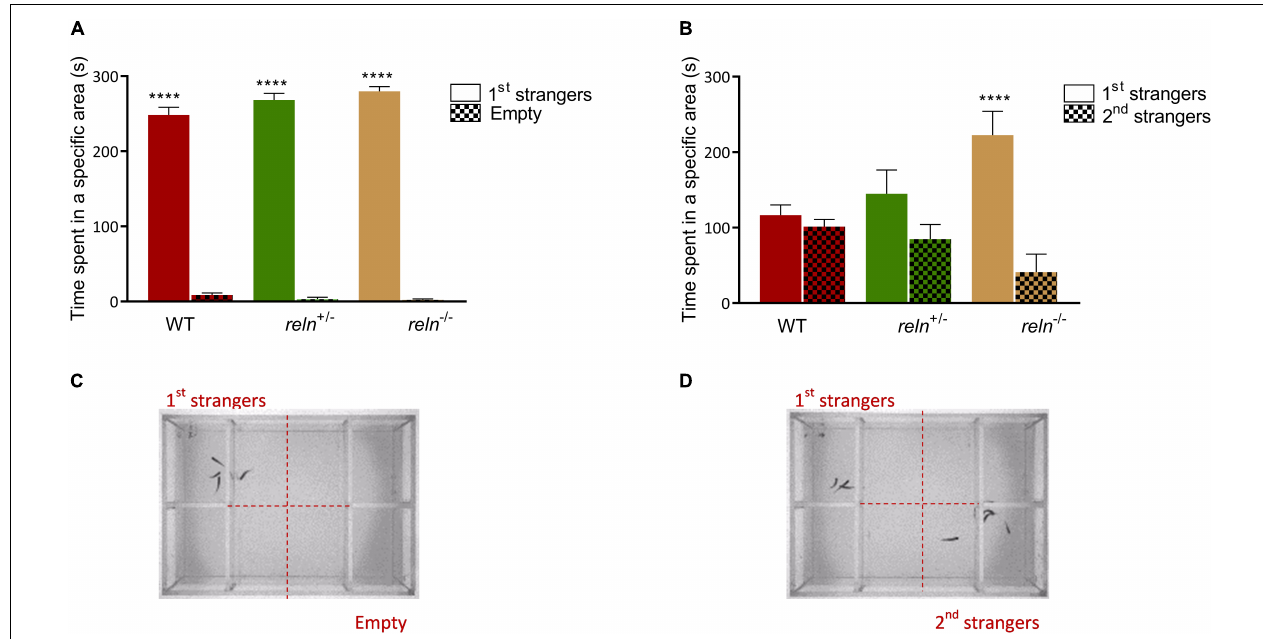
FIGURE 2 | Social preference test. (A) Social preference. WT, reln + / − and reln − / − show a significant preference to spend time near a group of unfamiliar fish [1st strangers; p < 0.0001 for all genotypes; two-way ANOVA followed by Sidak’s post hoc , genotype factor: F (2,62) = 1.818, p = 0.17, stranger factor: F (1,62) = 2392, p < 0.0001, interaction genotype × stranger: F (2,62) = 4.418, p = 0.02]. (B) Preference for social novelty. Both WT and reln + / − spend an equal amount of time near both groups of unfamiliar fish (1st and 2nd strangers; p = 0.99 for WT and p = 0.38 for reln + / − ). reln − / − do not switch preference to the second group of